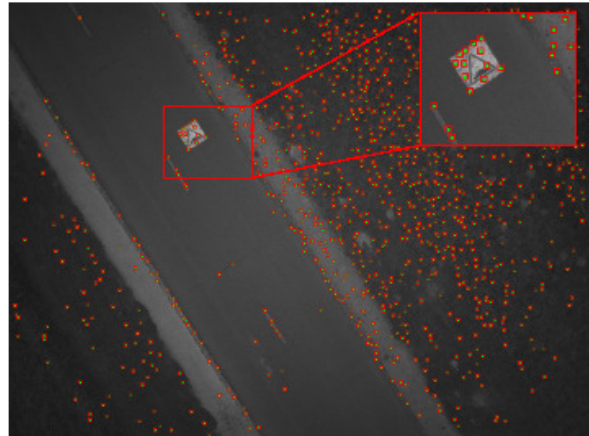
Figure 7. Search areas obtained by the gyrometers of IMU be- tween the first image and the 10 th image. The green points repre- sent the homologous points obtained by template matching. The size of each search area is 11 × 11 pixels. The resolution of image is 2560 × 1920 pixels. M × N = 60 × 60 . Threshold = 8